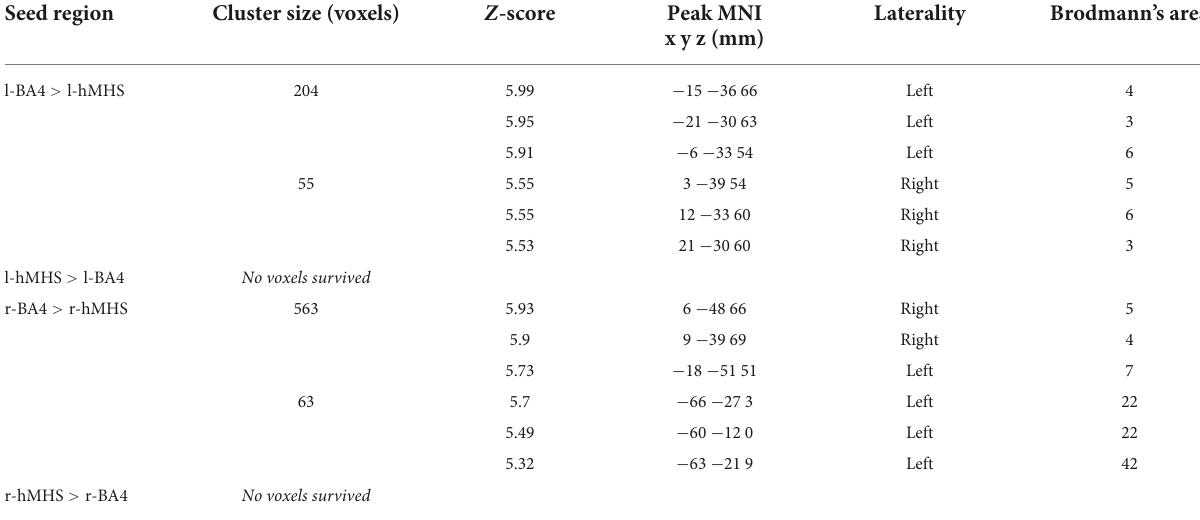
TABLE 2 Comparisons of the results obtained with the different ROIs as seeds, separately for the two brain hemispheres (l-hMHS vs. l-BA4 and r-hMHS vs. r-BA4; p < 0.05 FWE-corrected, extent of threshold k = 20 voxels). Seed region Cluster size (voxels) Z -score Peak MNI